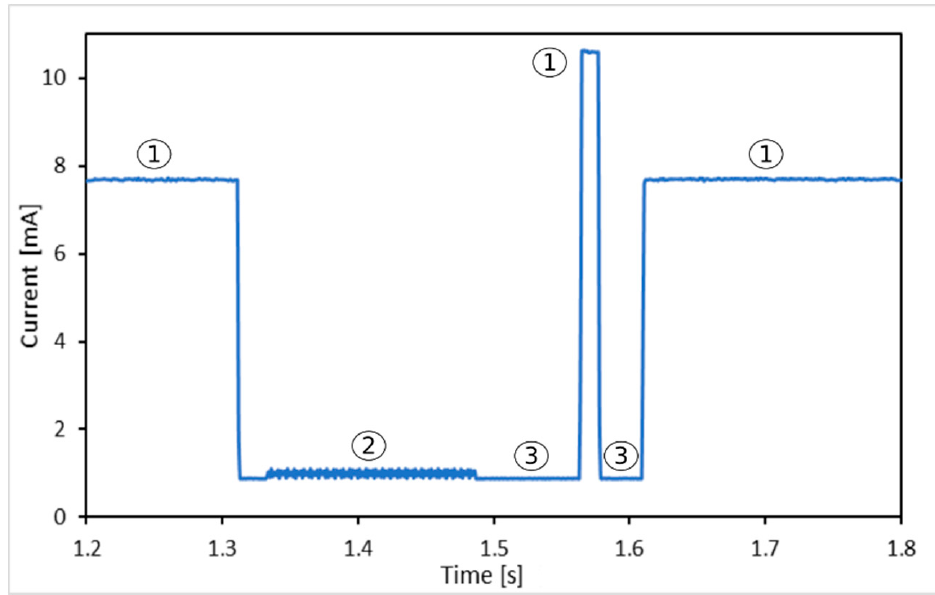
Figure 10. Power consumption of the tag after receiving a “read date” command at 4.2 V in the supercapacitor. As in other images, the numbers represent which element is the one that has the largest contribution to the consumption of the tag in that interval in each case: 1 is for the transceiver, 2 is for the EEPROM, and 3 is for the microcontroller. The EEPROM is active longer than in other commands since a concrete date has to be found in the whole memory. After that, the result is sent. Finally, the last implemented command is “write”. The entire process is shown in Figure 11. for the EEPROM, and 496.9 µ J for the